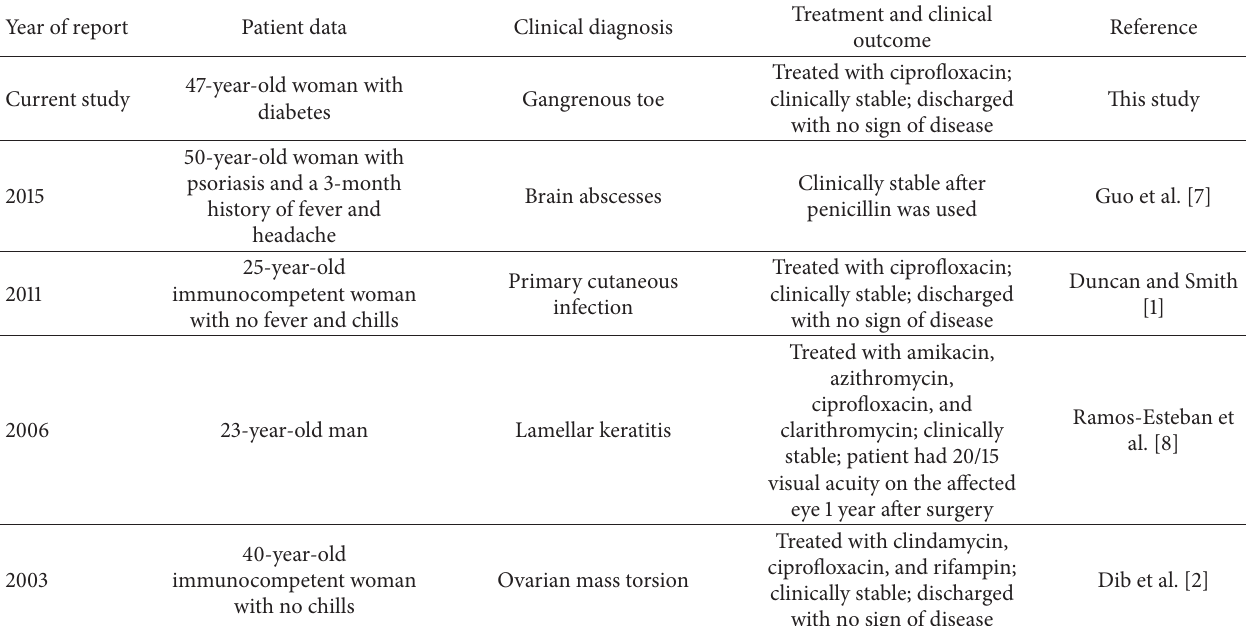
Table 1: Summary of B. megaterium -associated clinical cases in the